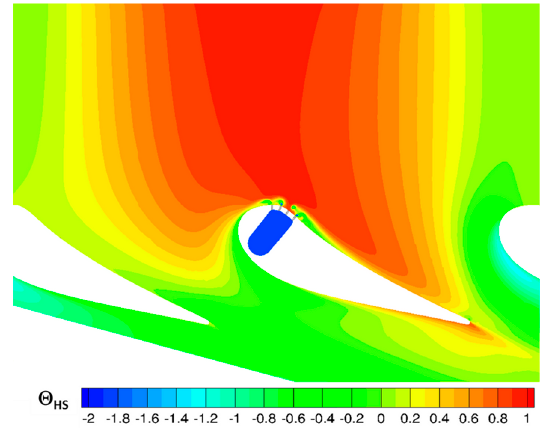
Figure 12. Predicted temperature ratio ( Θ HS ) at midspan ( Z/H = 0.5) for the hot streak aligned with the vane, combined with showerhead film cooling (blowing ratio BR = 3.0, coolant-to-mainstream mass flow ratio MFR =